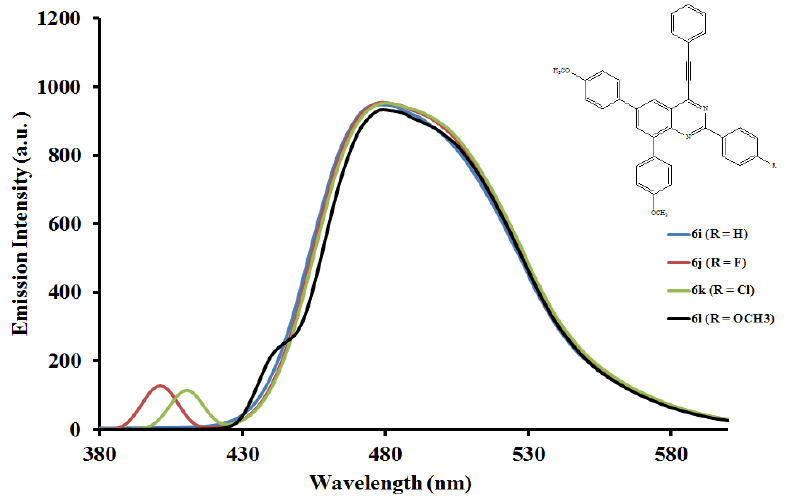
Figure 6. The emission spectra of compounds 6i – l ( λ ex = 380 nm) in CHCl (0.022 mmol/L) at